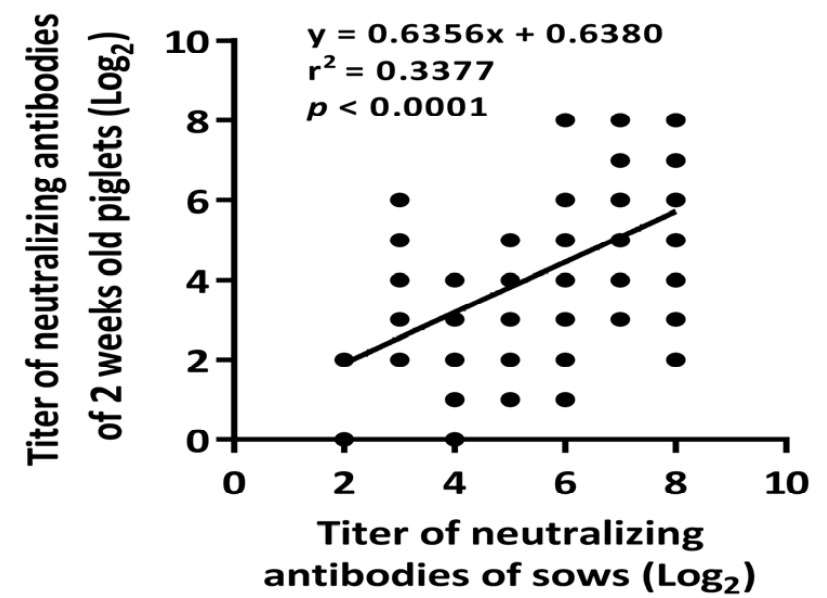
Figure 3. Correspondence of viral neutralizing antibodies between sows and their piglets. Black dots reflect each corresponding NAbs titer between sows and their piglets. The data correlation was analyzed by linear regression.